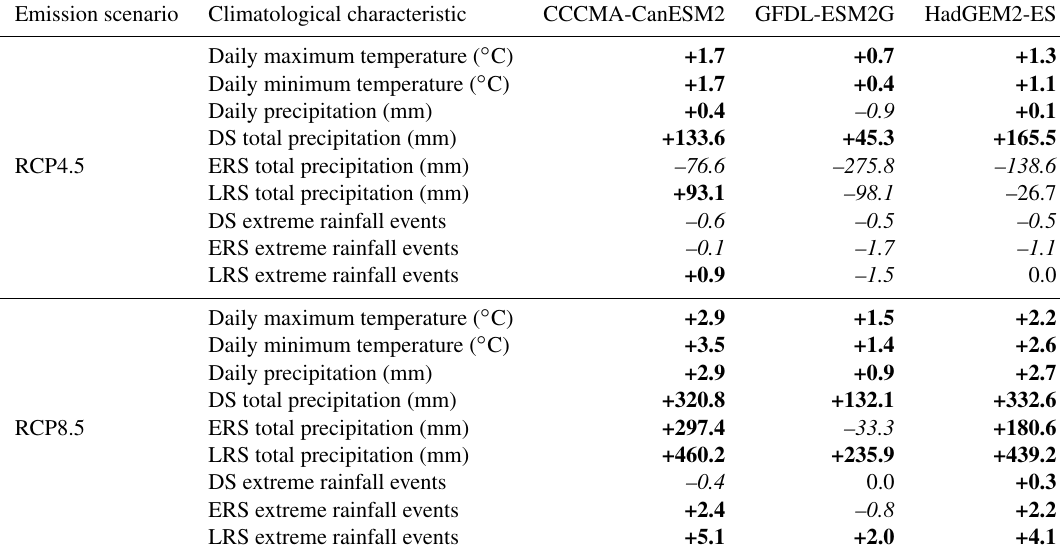
Table 5. Approximate changes of several climatological characteristics from 2005 to 2100. Bolded cells and italicized cells indicate increases and decreases of the specified